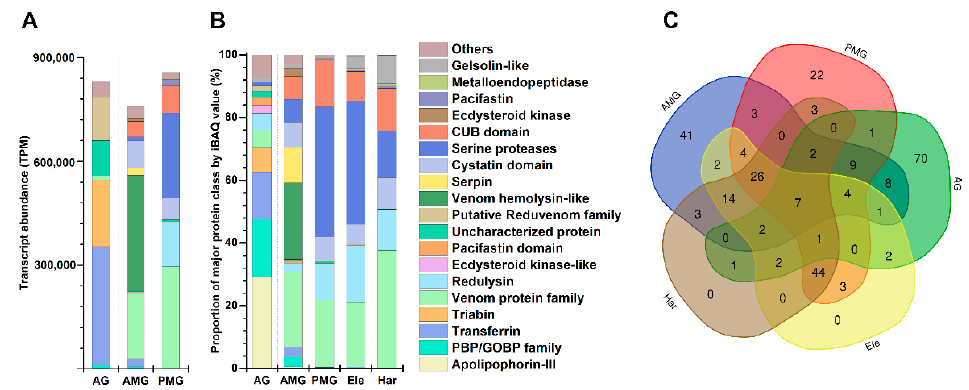
Figure 2. Secreted protein compositions of AMG, PMG, and AG of Platymeris biguttatus . ( A ) Transcript abundance of different classes of secreted proteins (normalized to transcripts per million, TPM) of each gland extract; ( B ) proportion of major classes of secreted proteins (normalized to intensity-based absolute quantification of proteins, iBAQ value) in each salivary sample; ( C ) a Venn diagram of protein components among the three glands, Ele, and Har. AG: accessory gland; AMG: anterior main gland; PMG: posterior main gland; Ele: electrostimulation; Har: harassment.